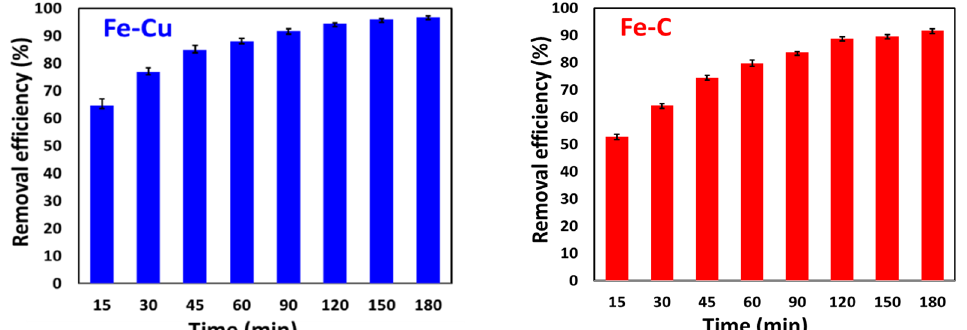
Figure 3. Effect of reaction time on CIP removal under Fe-Cu and Fe-C treatment.